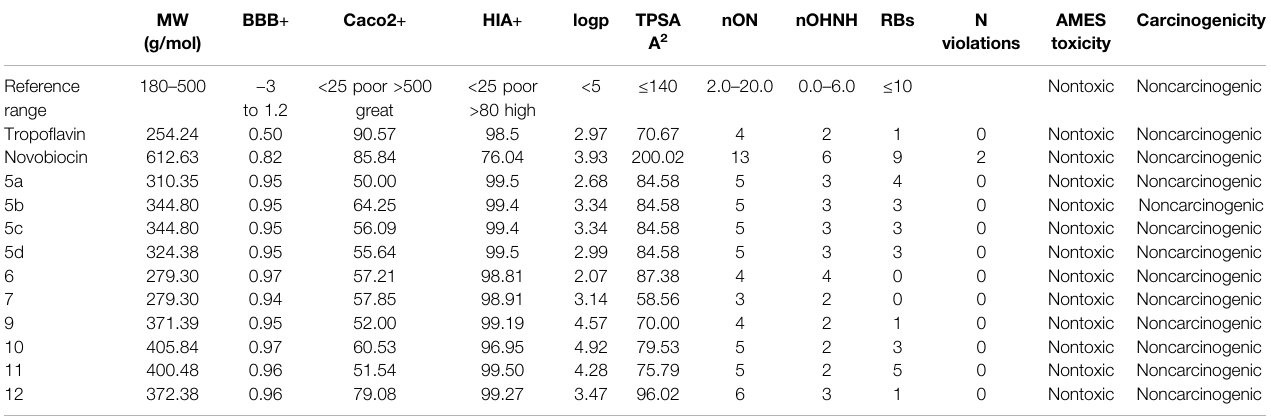
TABLE 4 | List of ADME/T and physicochemical properties of standard drugs and compounds 5 – 12 . MW